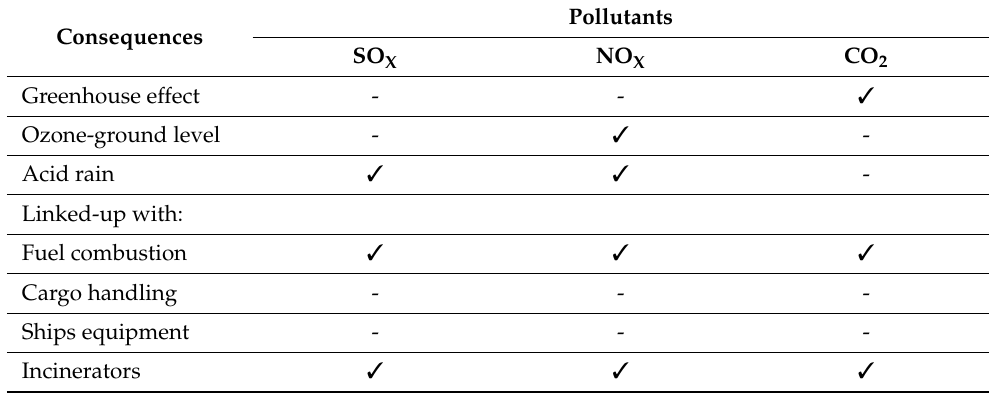
Table 1. Ship-produced gaseous pollutants and their effects on the environment according to